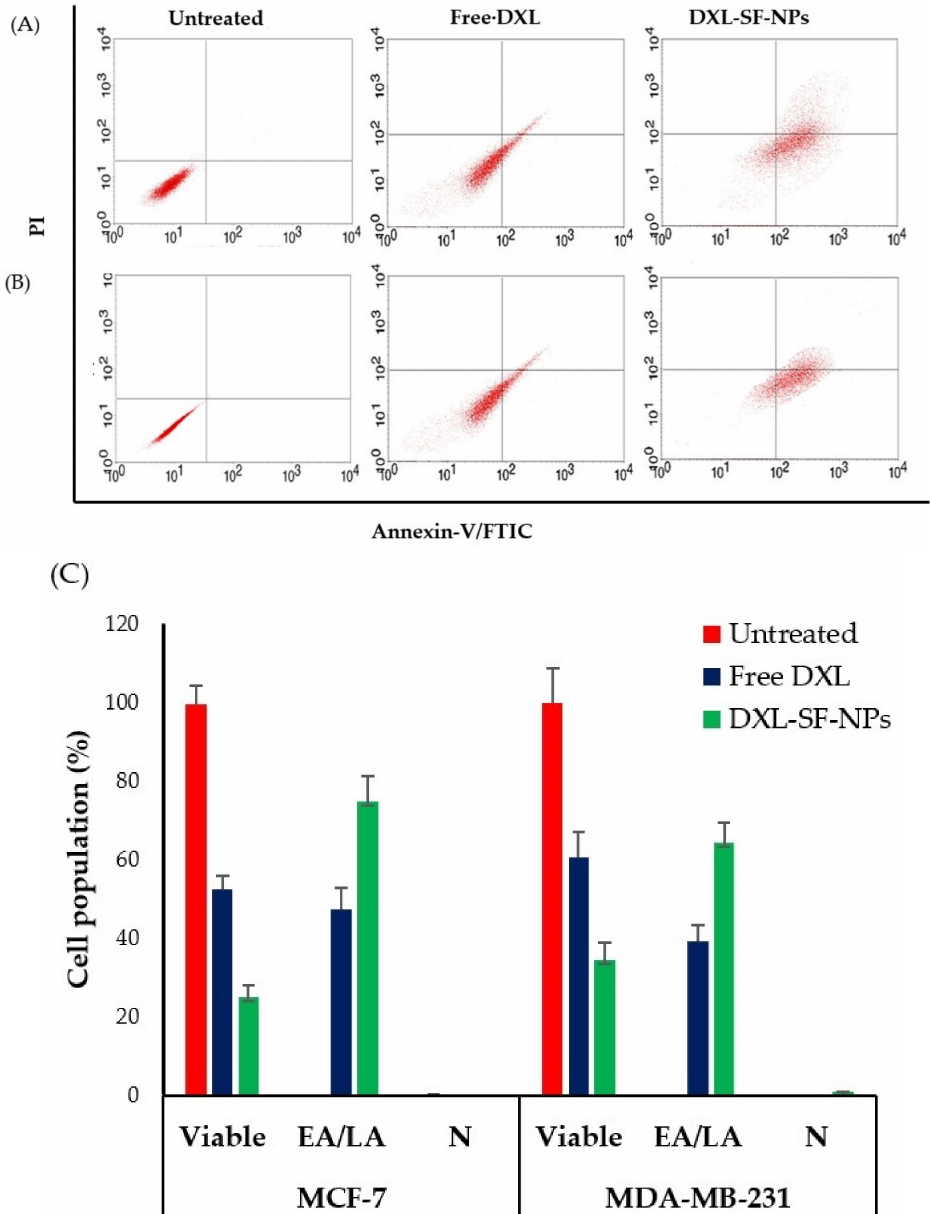
Figure 7. Flow cytometry analysis data from annexin V-FITC staining. Dot plots representing the distribution of apoptotic cells of ( A ) MCF-7 cells and ( B ) MDA-MB-231 cells following staining with annexin V-FITC and propidium iodide. ( C ) Quantitative analysis of the percentage of apoptotic cells upon treatment with either free DXL or DXL-loaded